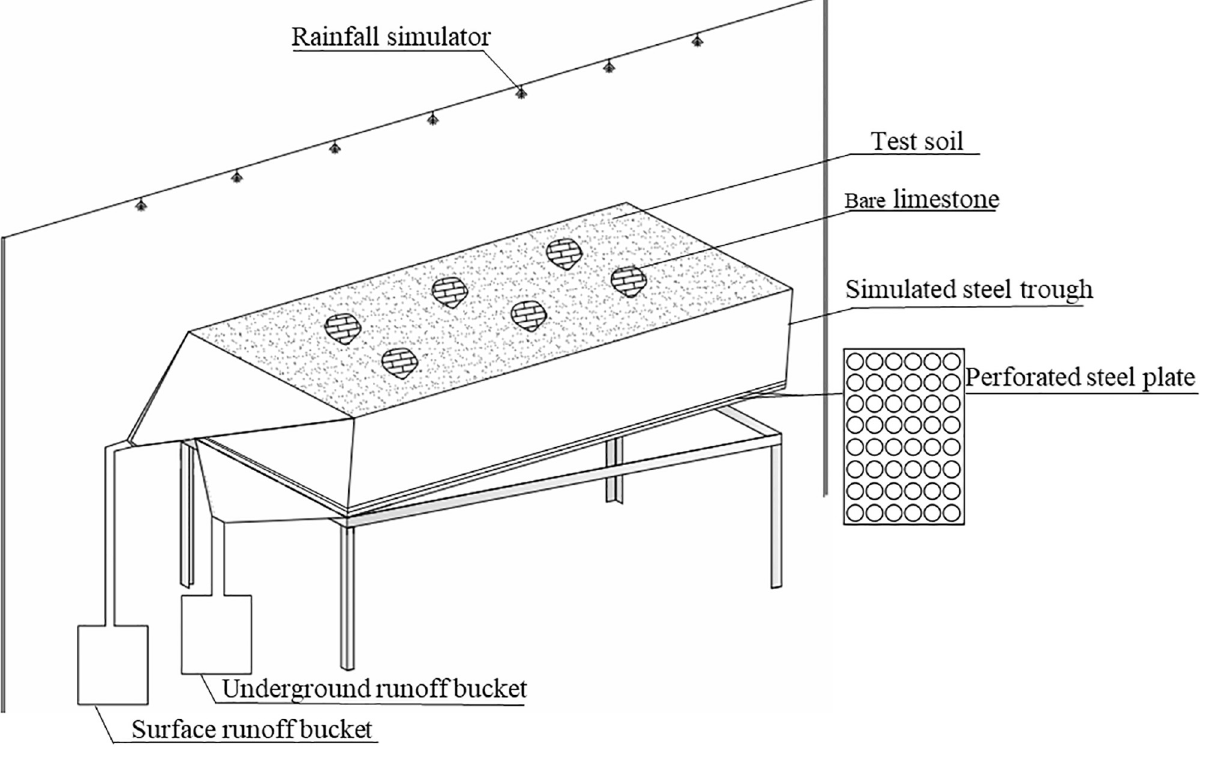
Fig 3. Sketch of the experimental